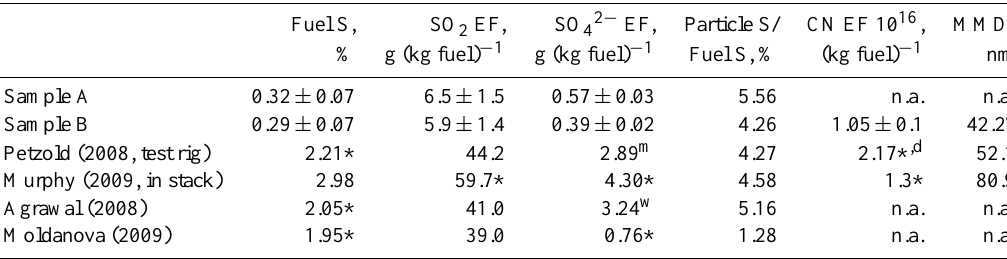
Table 3. Emission factors (EF) for SO 2 , SO 42 − , and particulate matter (CN). Particulate sulphur ratios to the total fuel sulphur content were calculated from the SO 42 − to SO 2 EF ratios. Mass median diameters (MMD) were calculated from the SO 42 − and CN EFs ratio assuming spherical particle shape and 1.84gcm − 3